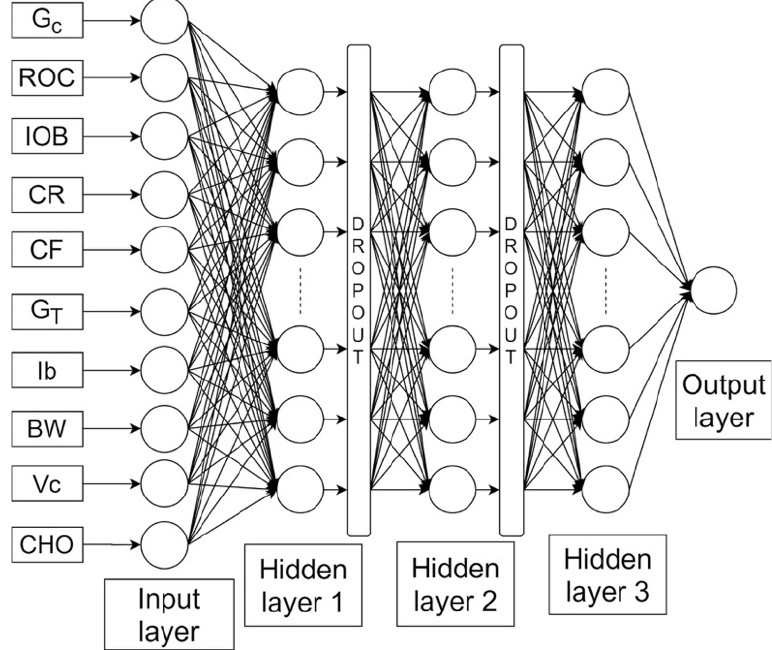
Figure 2. Structure of a NN able to correct meal insulin doses computed by the SF (adapted from Figure 1 of [37]).